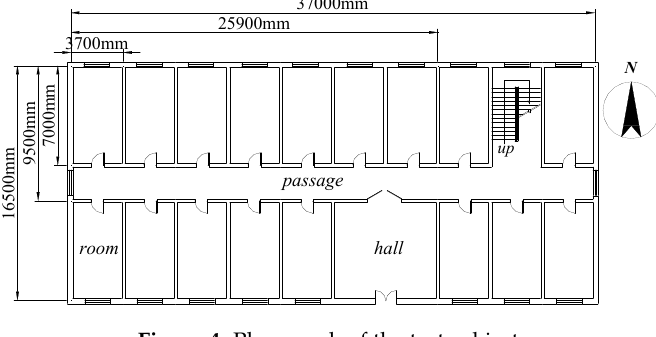
Figure 4. Plan graph of the test subject.